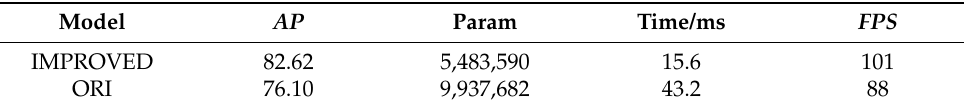
Table 2. The comparison of model scores before and after enhancement.